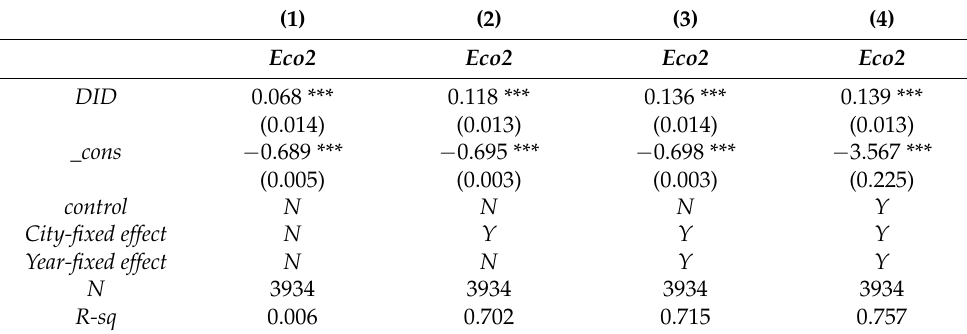
Table 3. Replacing dependent